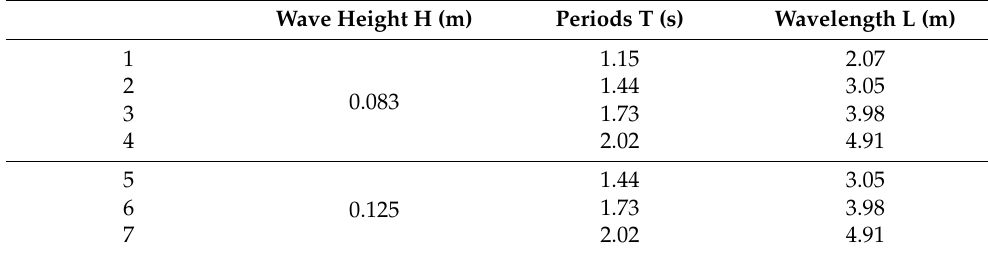
Table 2. Wave parameters used in the wave experiment. Wave Height H